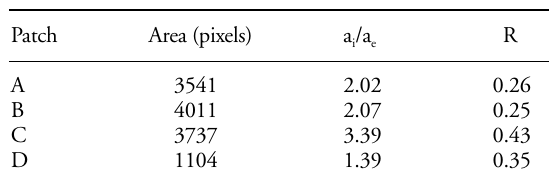
Table 1. Calculation results for four forest patches in the Belgian Campine region. Patch